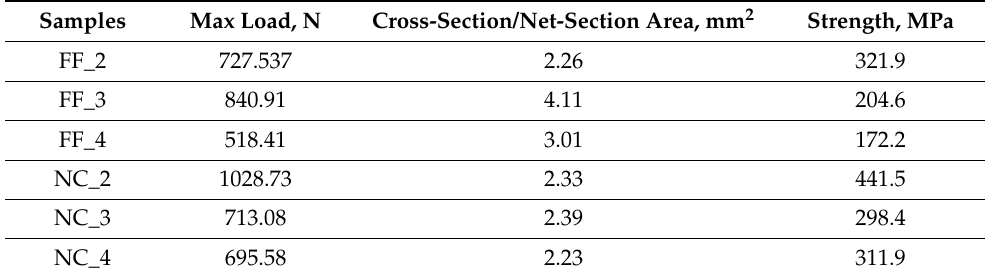
Table 4. The tension strength of each